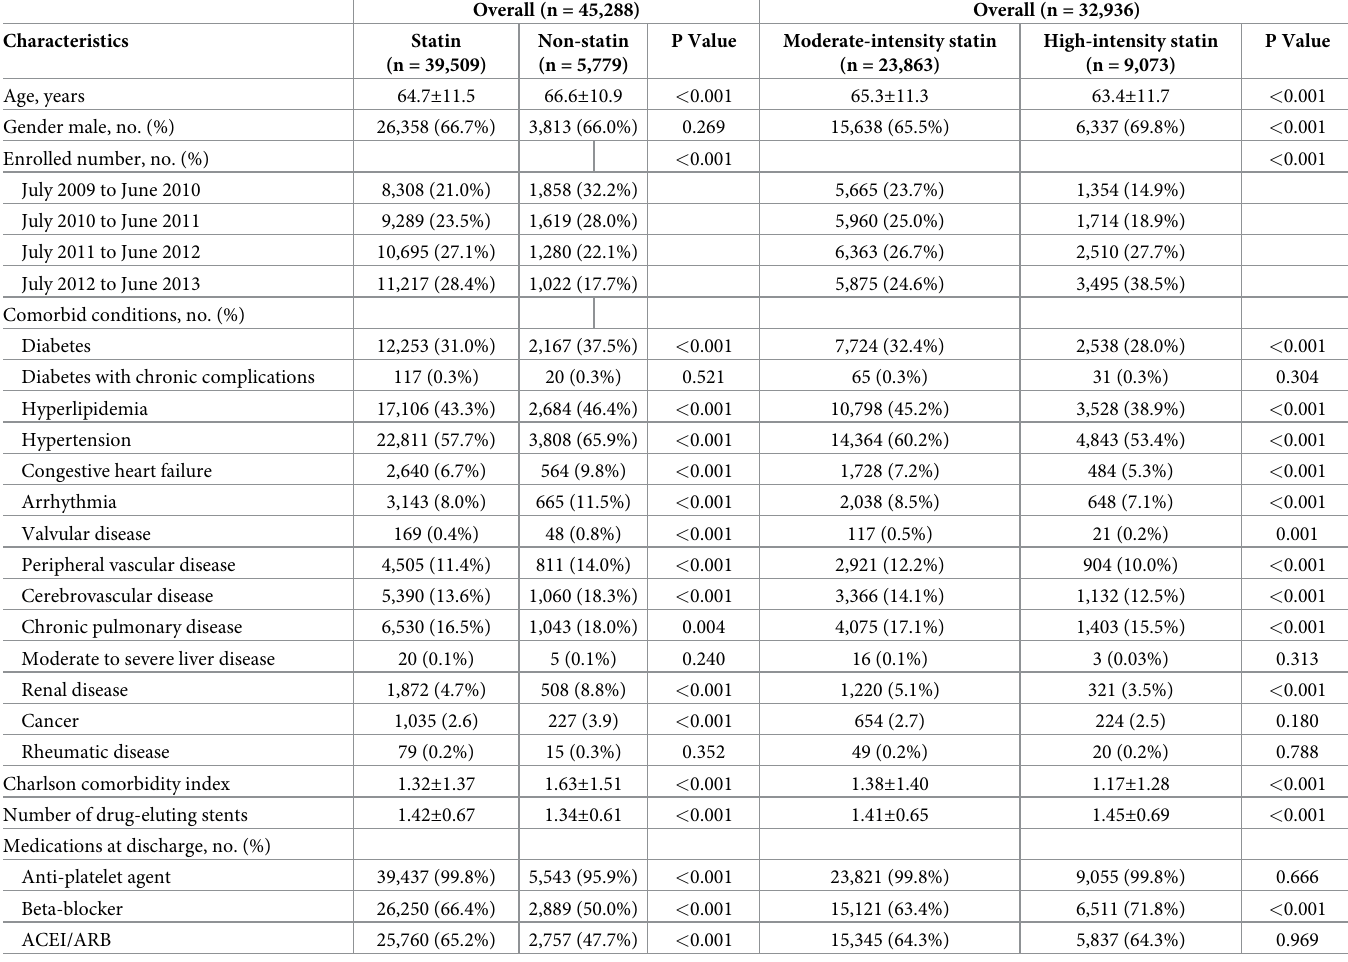
Table 1. Characteristics of patients undergoing percutaneous coronary intervention with drug-eluting stents for angina according to statin